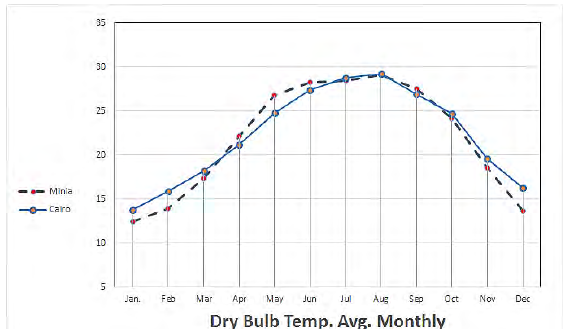
Figure 1. Comparison between Al Minya and Cairo cities of the Dry Bulb Temp. Avg. Monthly. Al-Minya has the highest differences between summer and winter.